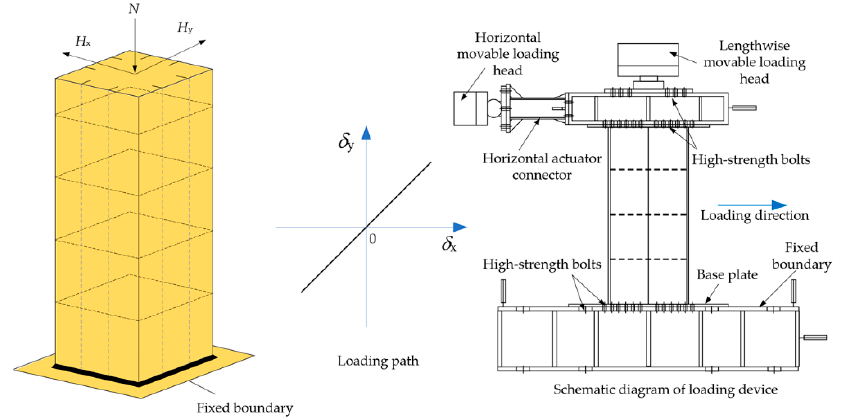
Figure 7. Loading path.